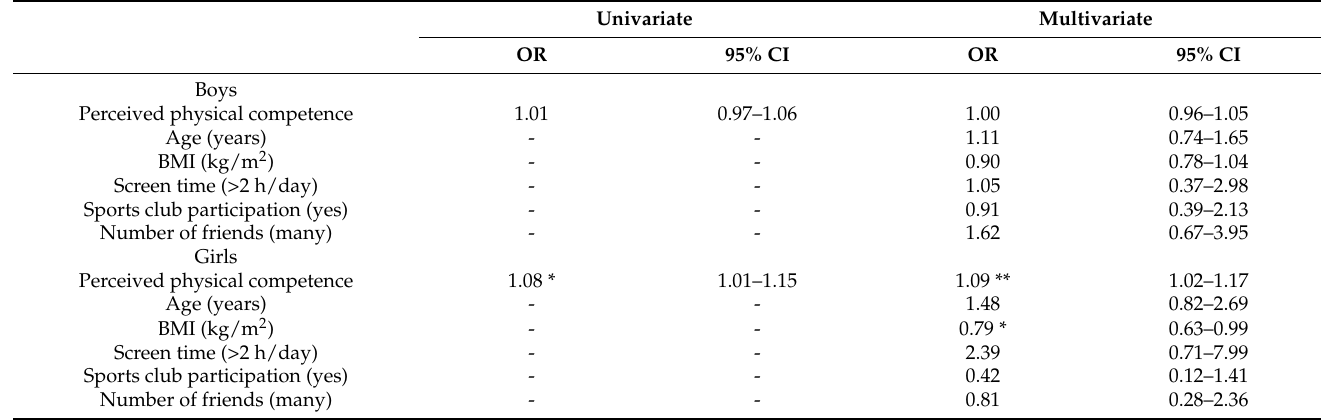
Table 3. Logistic regression analysis assessing the relationship between perceived physical compe- tence and outdoor play for each